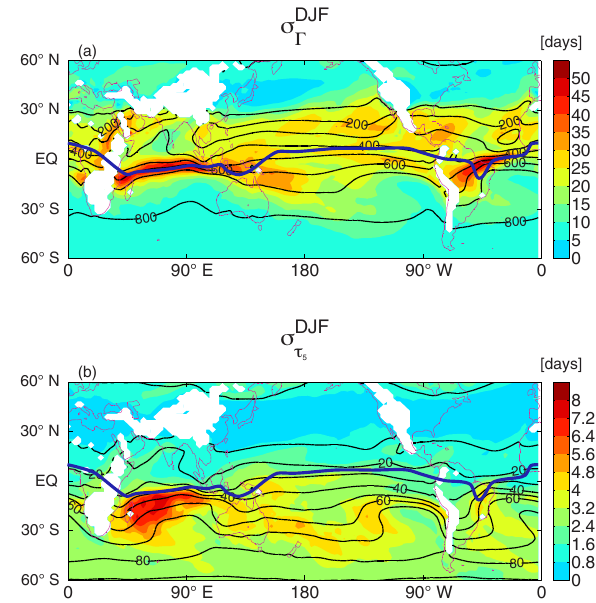
Figure 8. As in Fig. 4 but for DJF interannual standard